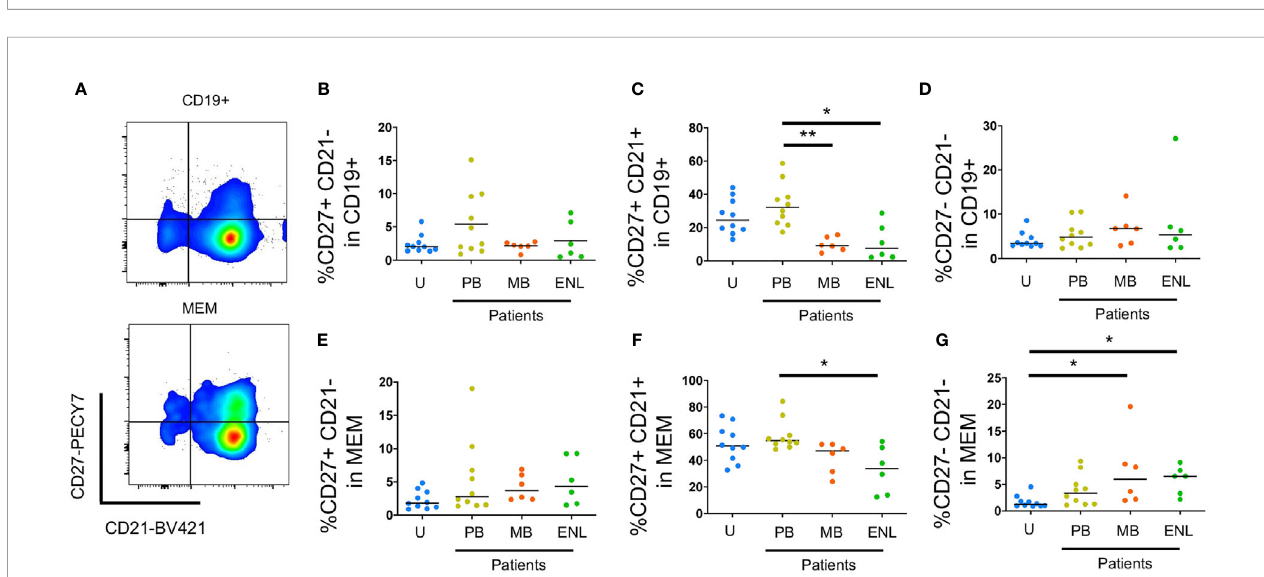
FIGURE 2 | Circulating memory B cells sorted by CD27 and IgD. PBMC of uninfected individuals (U), paucibacillary patients (PB), multibacillary patients in type II reaction (ENL) or not (MB) were freshly stained and analyzed by fl ow cytometry. (A) Pseudocolor plot pro fi le for CD19+ B cells (top) and MEM B cells (bottom) for CD27 and IgD expression. Percentage of CD27+IgD+ (B) , CD27+IgD- (C) and CD27-IgD- (D) cells among CD19+ B cell subpopulation or MEM B cell subpopulation ( E – G , respectively). Each dot represents one donor and lines represent median values for each group. Signi fi cant values (*) were calculated by Kruskal-Wallis tests with Dunn ’ s multiple comparisons test. *p < 0.05; **p < 0.005; ***p < 0.0005.